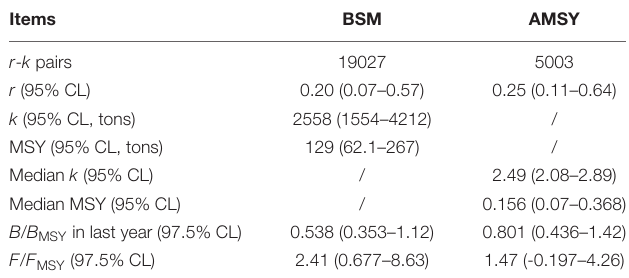
TABLE 2 | Results of the BSM and AMSY analyses.